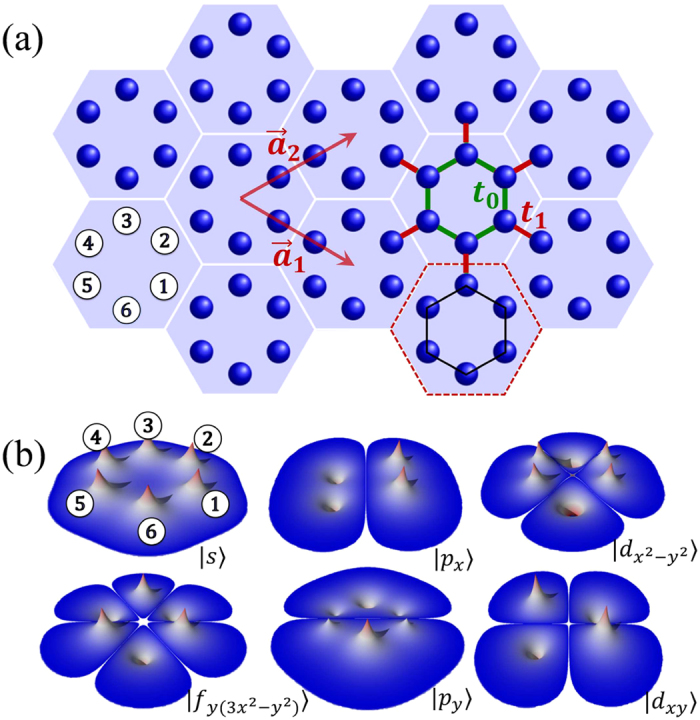
Hopping texture in honeycomb lattice and emergent orbitals.(a) Honeycomb lattice with hopping energies between NN sites: t0 inside hexagons as denoted by the green bonds and t1 between hexagons by red ones. The red dashed hexagon is the primitive cell of triangular lattice with lattice vectors ,  and lattice constant . Numbers  in circle index atomic sites within a hexagon. (b) Emergent orbitals in the hexagonal artificial atom.